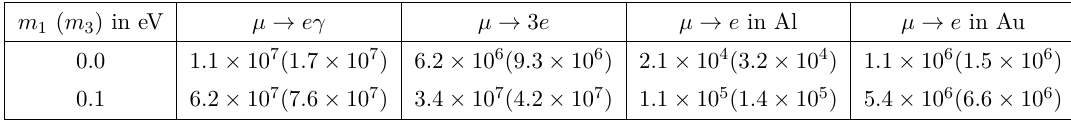
2 from various LFV processes for the lightest neutrino mass, Table 3 . Upper limit on m ∆ m Φ v 3 | y 0 34 y 0 45 | 2 m 1 ( m 3 ) = 0 . 0 and 0 . 1 eV in NH (IH) light neutrino mass